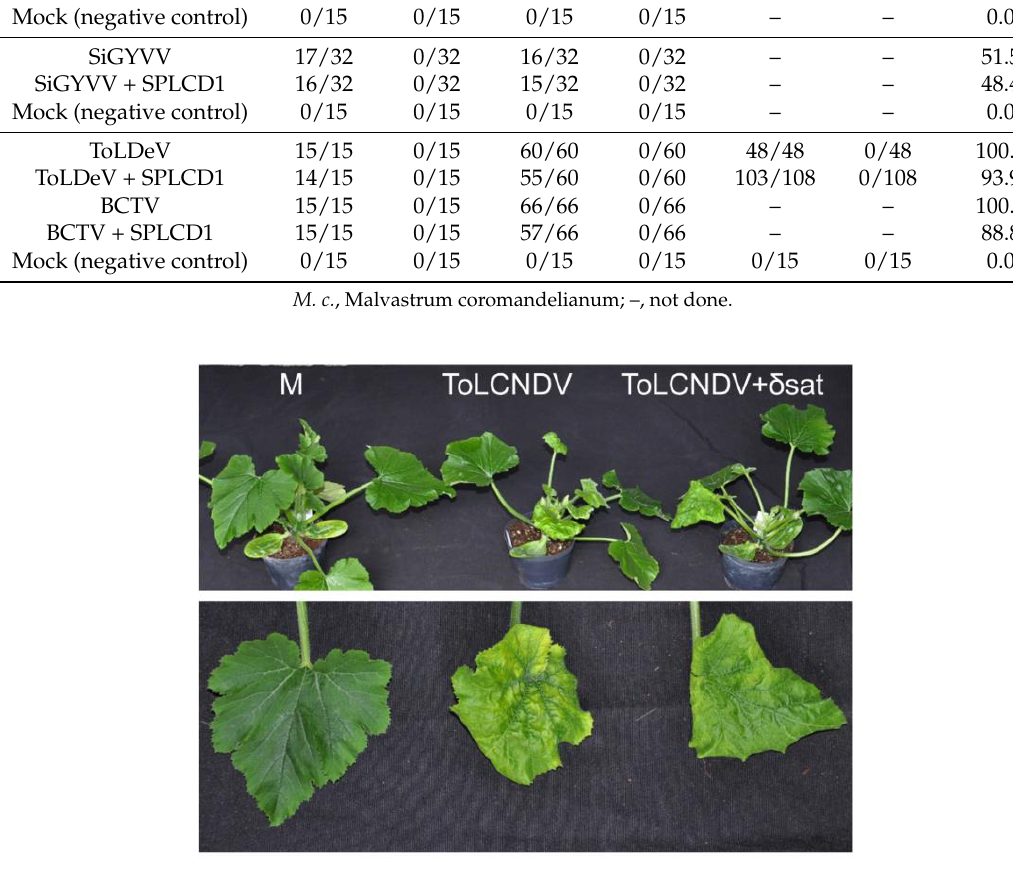
Figure 6. Symptoms caused by tomato leaf curl New Delhi virus (ToLCNDV) alone or in combination with sweet potato leaf curl deltasatellite 1 ( δ sat) on agroinoculated zucchini plants. Mock-inoculated plants (M) are shown at the left of each panel. Photographs of representative plants were taken at 30 days post-inoculation.